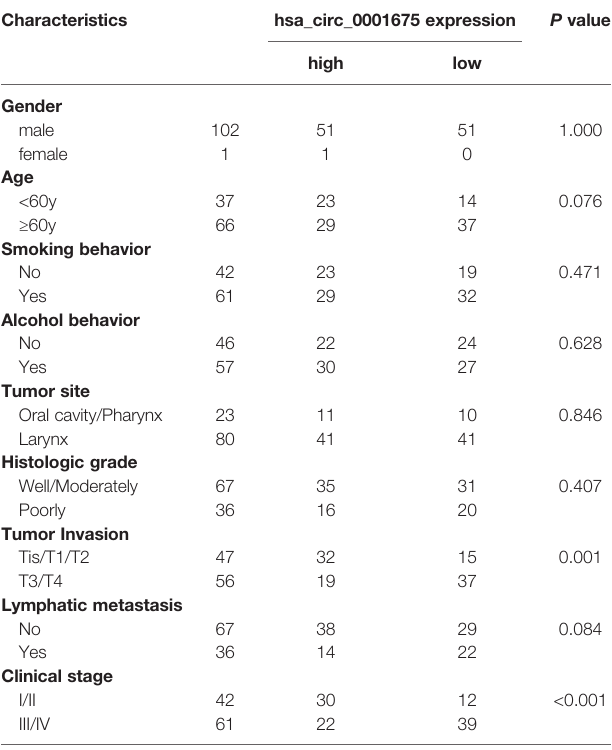
( Figure 4B ): hsa-miR-330-5p, hsa-miR-498, hsa-miR-532-3p, hsa-miR-577, hsa-miR-1248, and hsa-miR-1305. One thousand seven hundred and fi fty-three mRNAs in the TCGA database